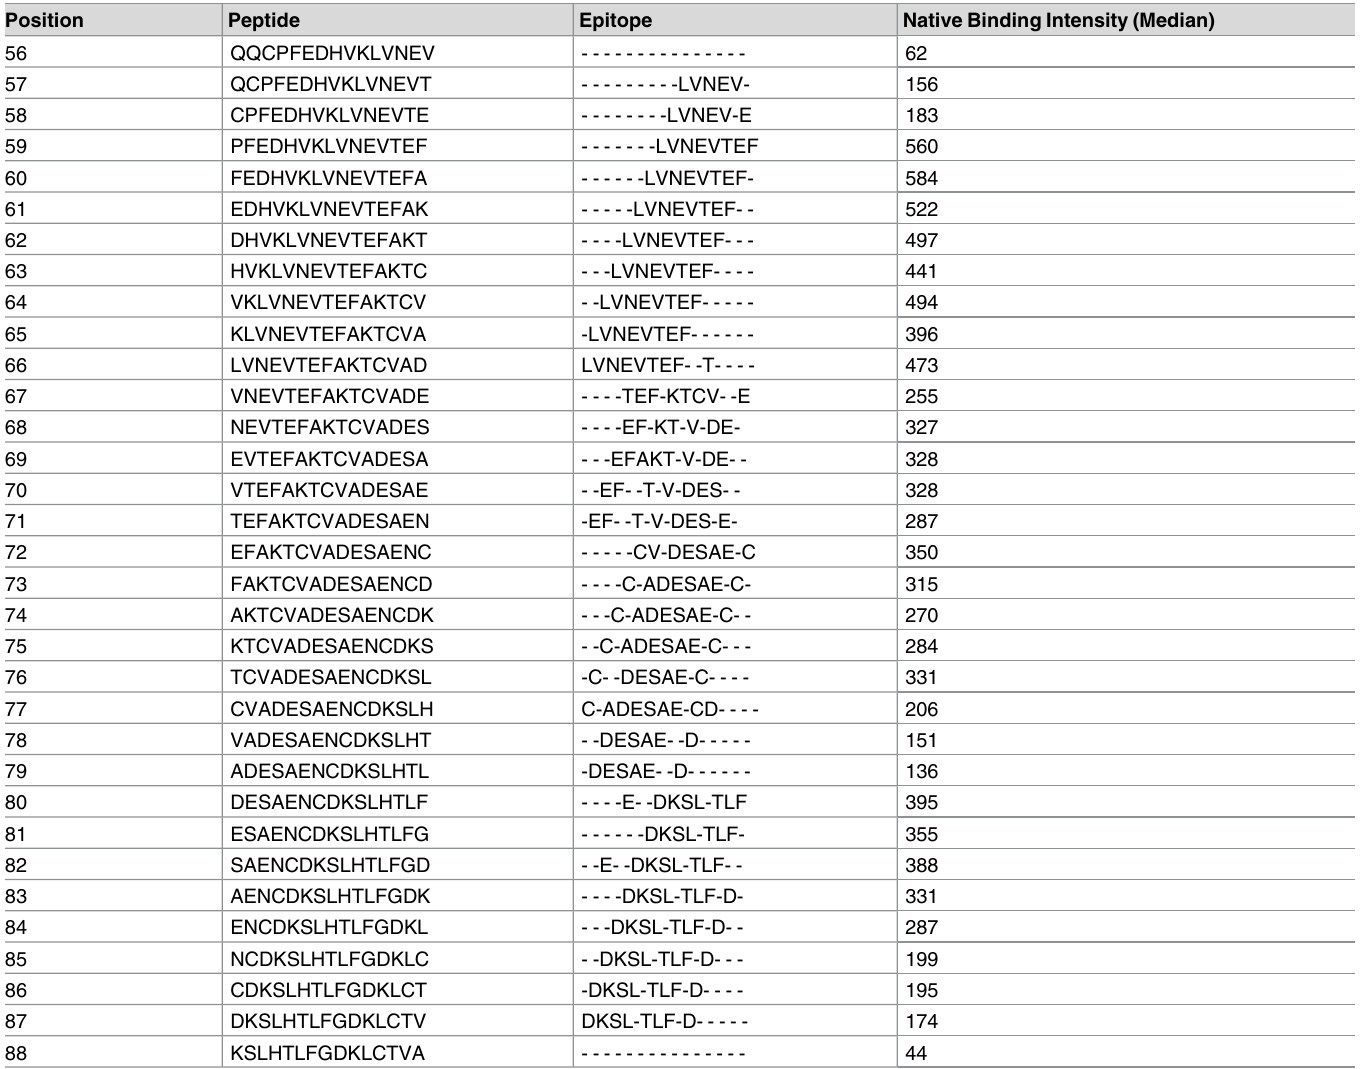
Table 1. Example of target-specific positions of individual peptides. The table shows output of 33 overlapping peptides mappingthe positions56 to 88 of the HSA protein sequence.Positionsidentifiedas being important for binding(identifiedby the Dunnett’s test of completesingle-amino acid substitutionsat the p < 0.0001level) are highlightedwhereasdashes indicatepositionsnot involvedin binding.The mediansignal of copies of the corresponding native peptide is shown.